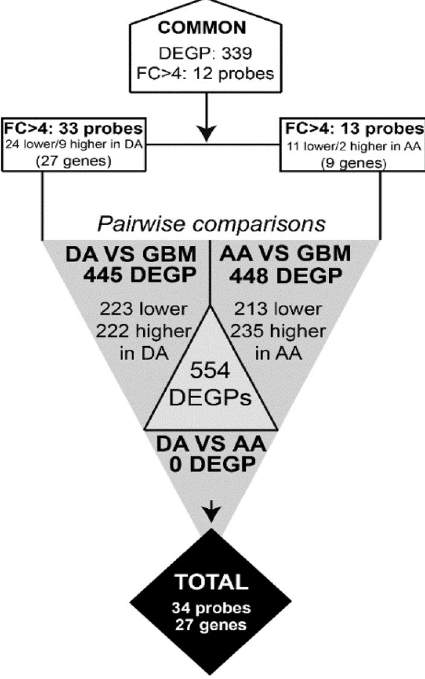
Figure 1. Number of differentially expressed gene probes in samples corresponding to distinct tumor subtypes from the discovery cohort. Differentially expressed probes were identified by pairwise comparisons based on p-values < 0.05. The number of overexpressed and underexpressed probes in DA and AA versus GBM are shown. DEGP, differentially expressed gene probes; DA, diffuse astrocytoma; AA, anaplastic astrocytoma; GBM, glioblastoma; FC, fold-change in gene expression